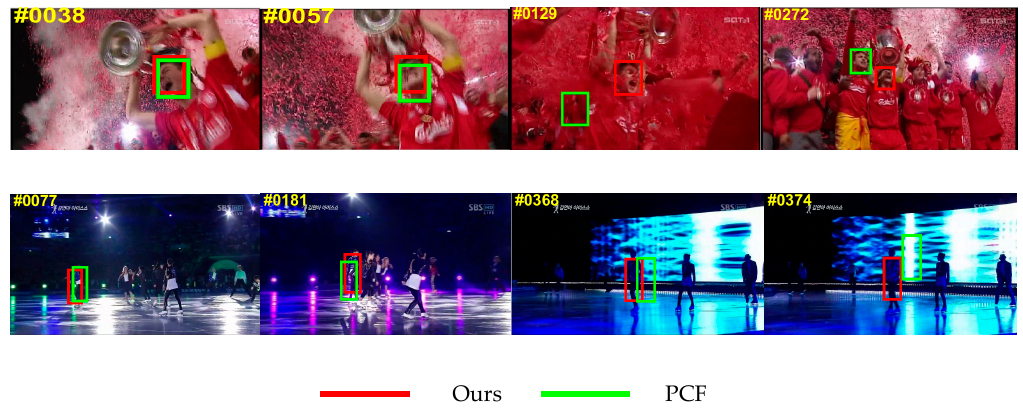
Figure 4. Comparison experimental results of the proposed tracker and the baseline tracker PCF.